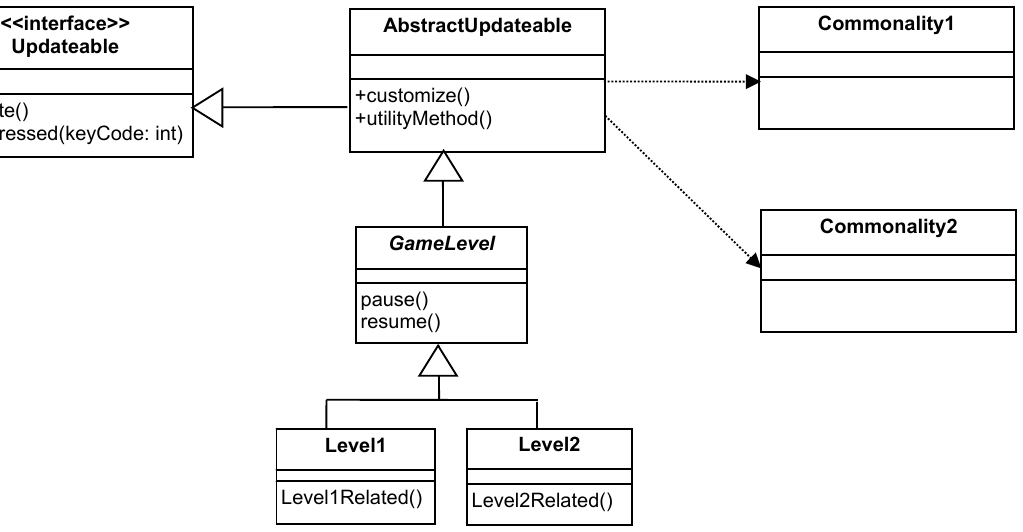
Figure 21: Unrelated Levels Pattern with Strategy Pattern. Figure 21. Unrelated Levels pattern with Strategy